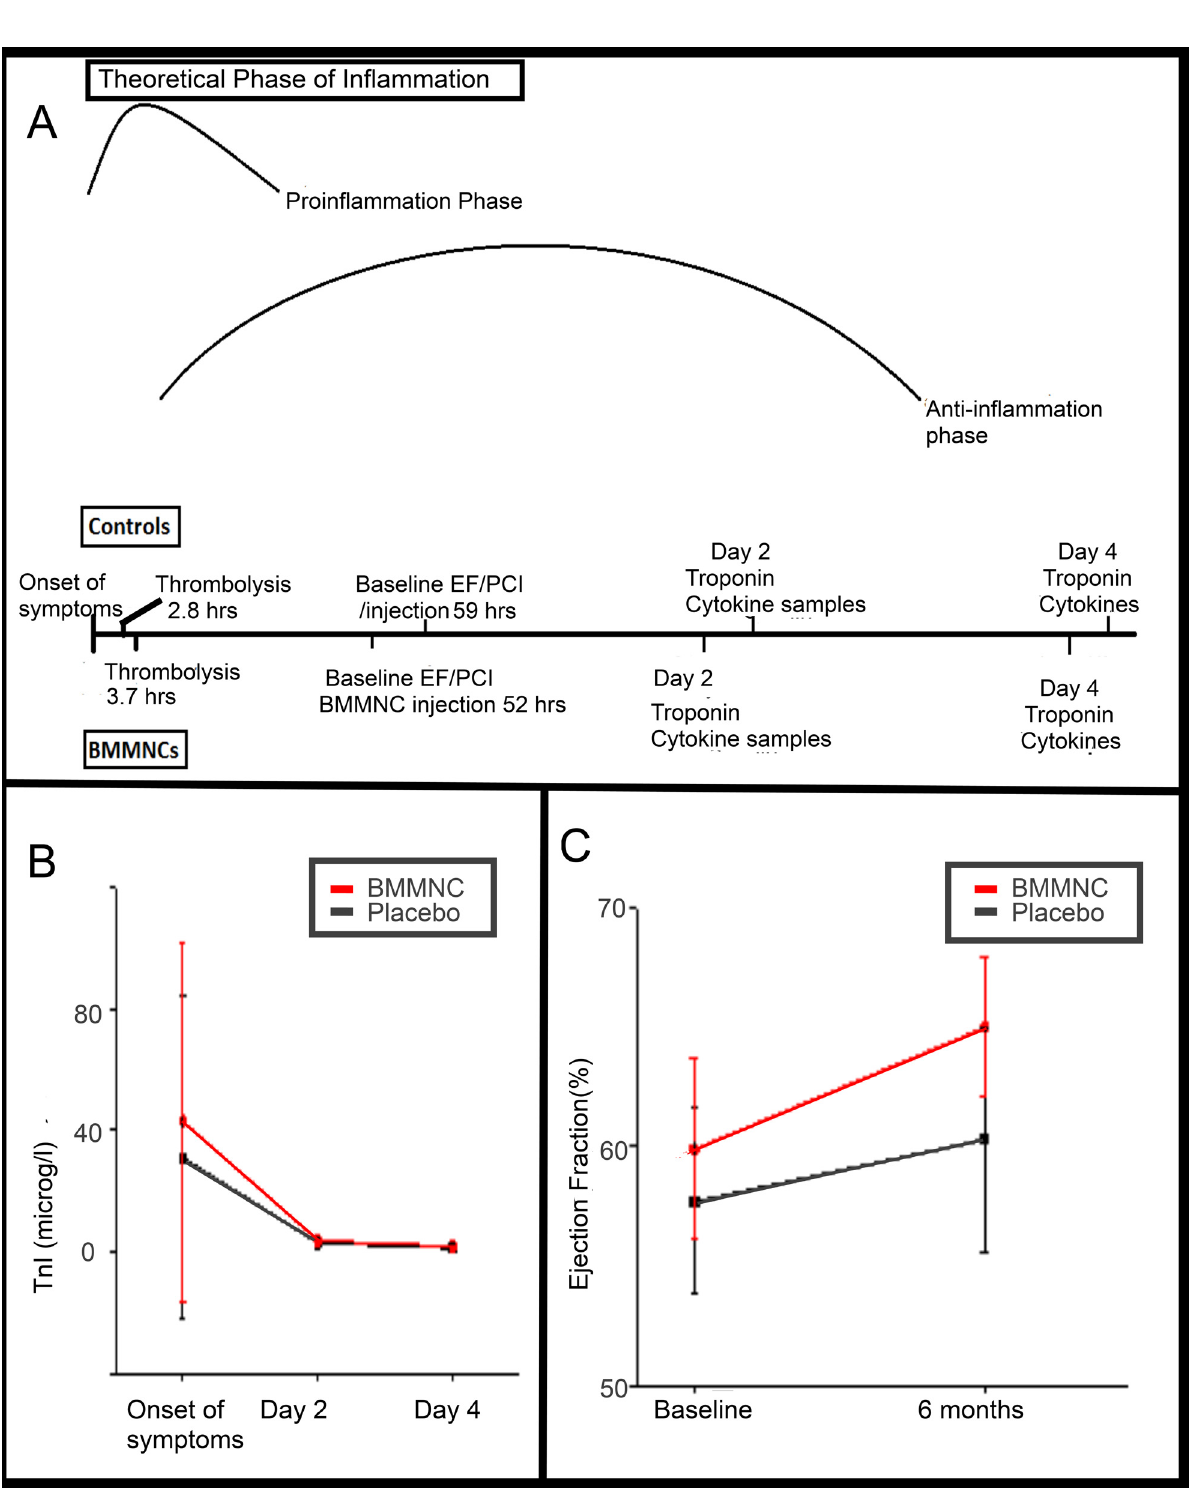
Fig 1. Study design and signs of STEMI. A) Thrombolysis was performed during proinflammatory reaction launched by ischemic condition. PCI and injection followed 40 – 77 hours (mean time presented in the figure) after onset of symptoms and cytokine sampling was performed 2 and 4 days after that. B) Troponin level were measured immediately after onset of symptoms and 2 and 4 days later. As a sign of STEMI, the levels increased similarly in both study groups but declined 2 days later. No statistically significant differences existed (control N = 12; BMMNC n = 14; p = 0.71). C) Contrast opacification of left ventricular angiograms was used to analyse EF at the baseline and after 6 months to evaluate effect of BMMNC transplantation on cardiac function.